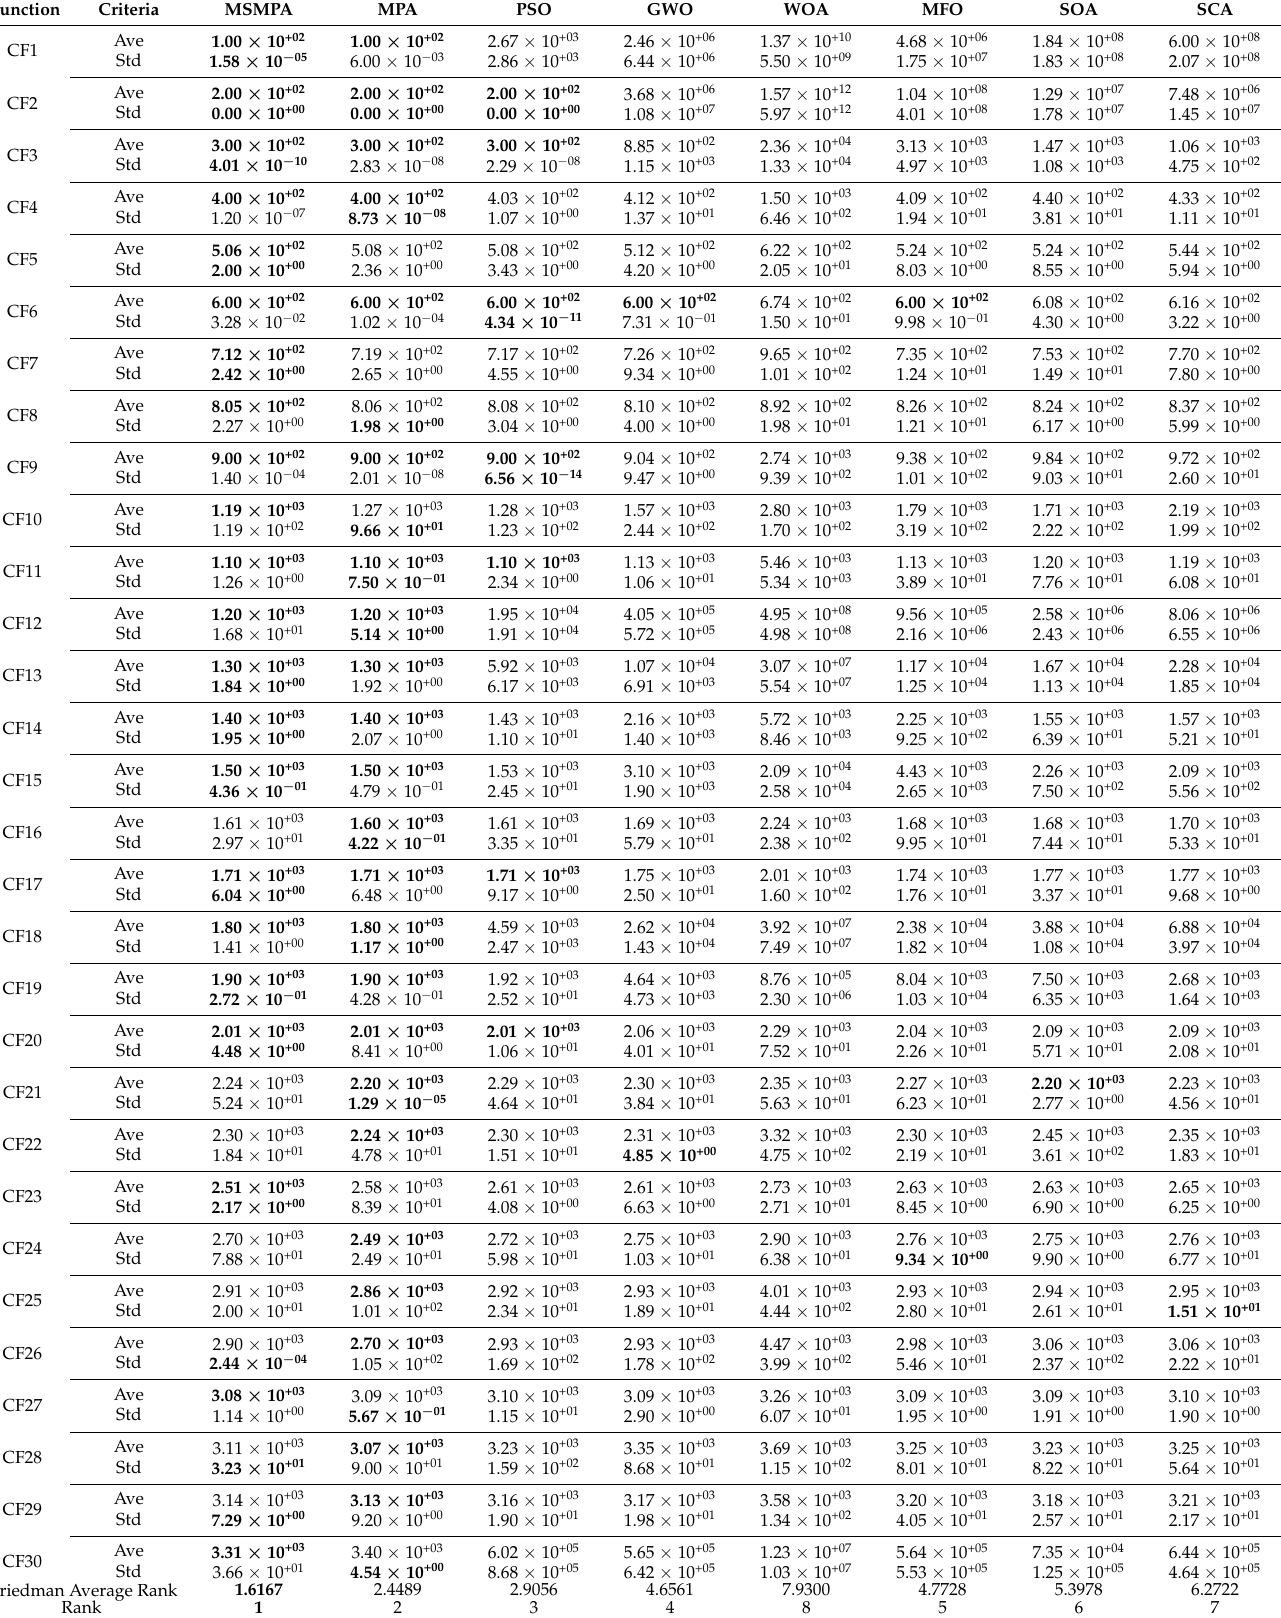
Table A2. CEC2017 optimization function